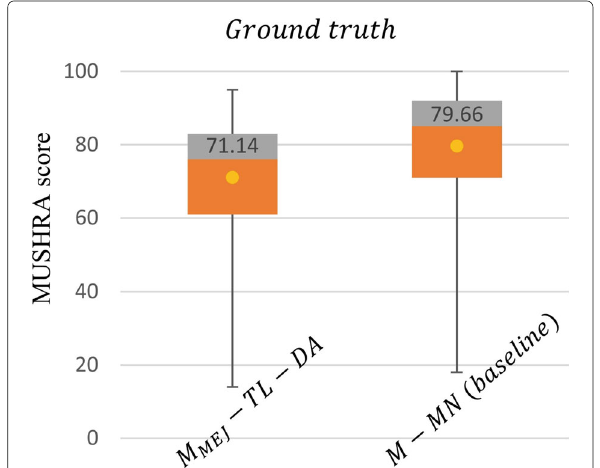
Fig. 12 Speaker similarity comparison of speech samples generated using our proposed model and using the baseline model, in relation to the ground